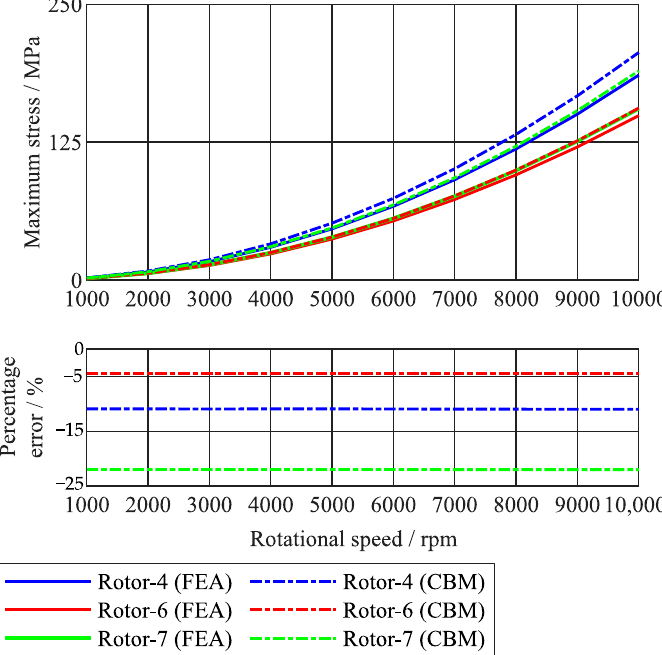
Figure 10. Stability analysis of the CBM method vs. rotor speed for different rotor geometries.